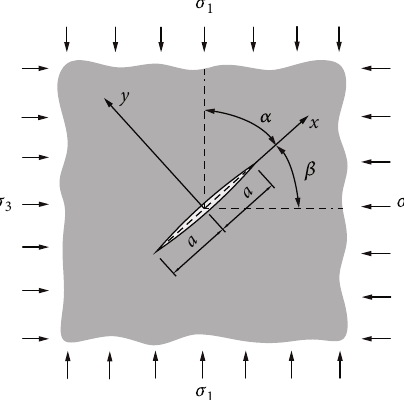
Figure 3: Nonclosed crack subjected to